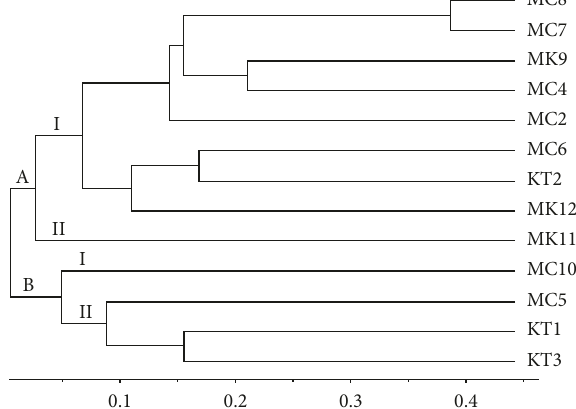
Figure 5: Dendrogram showing the genetic relationship of rhizobia isolated from soils of lower eastern Kenya after analysis of binary matrix data of BOX-PCR products using UPGMA method and Jaccard’s similarity